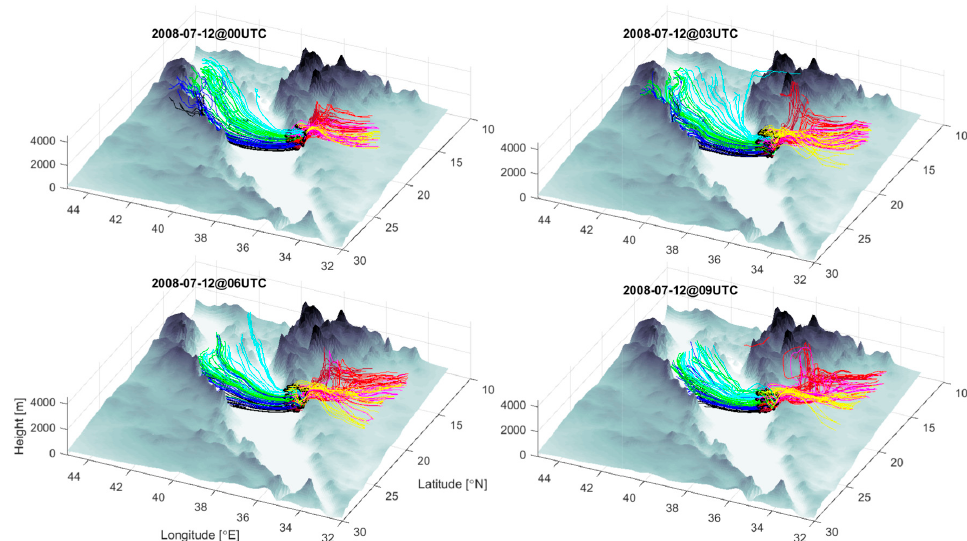
Figure 11. Forward time (black) and backward time (red) trajectories, initiated at the time indicated on each frame and within a horizontal patch (blue area) lying at z = 100 m and where the wind speed exceeds 15 m/s. Trajectories are integrated backward to 12 UTC on 12 July 2008 and forward in time to 24 UTC on 12 July 2008. The arrows point to trajectories that originate from the upstream cell containing strong downdrafts. These trajectories are colored green.